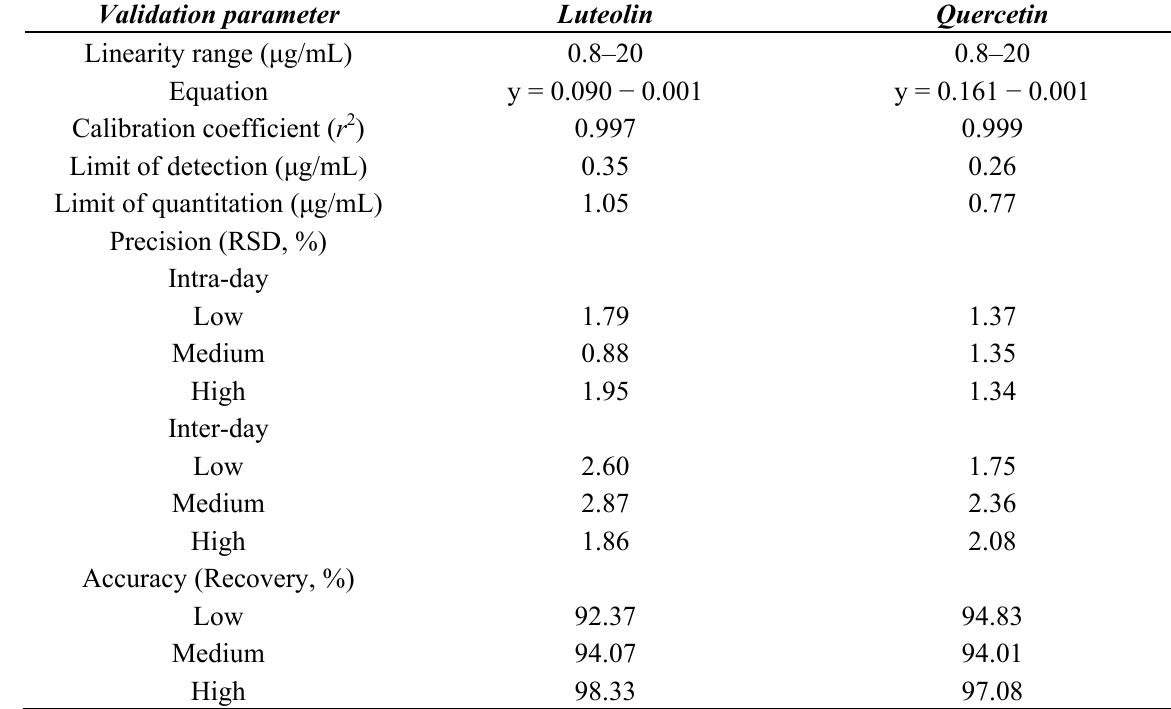
Table 1. Validation data of total flavonoids